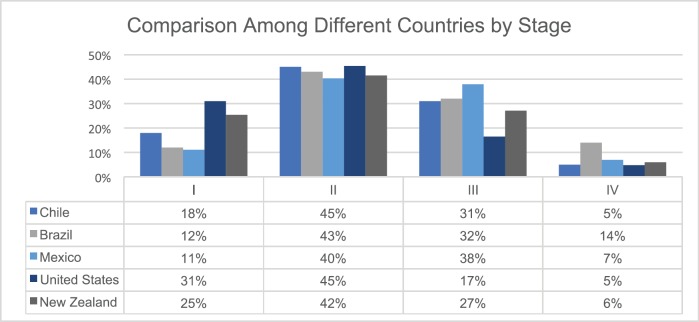
BC stages at diagnosis in selected countries in Latin America [16, 17, 23], USA [26] and New Zealand [27].